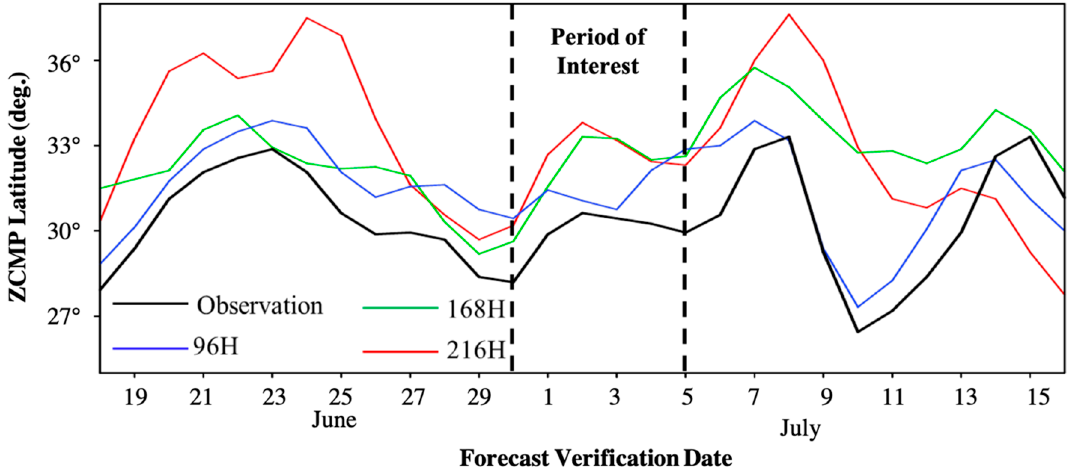
Figure 4. The observed ZMCP (station data, black line) and the 96-h, 168-h, and 216-h deterministic ECMWF forecasted ZMCP of the Meiyu rain band (blue, green, and red lines, respectively) for the Meiyu precipitation season from 18 June to 16 July 2016. The thick dashed black line represents the starting (0000 UTC 30 June 2016) and ending point (0000 UTC 5 July 2016) of the period of interest for the study.